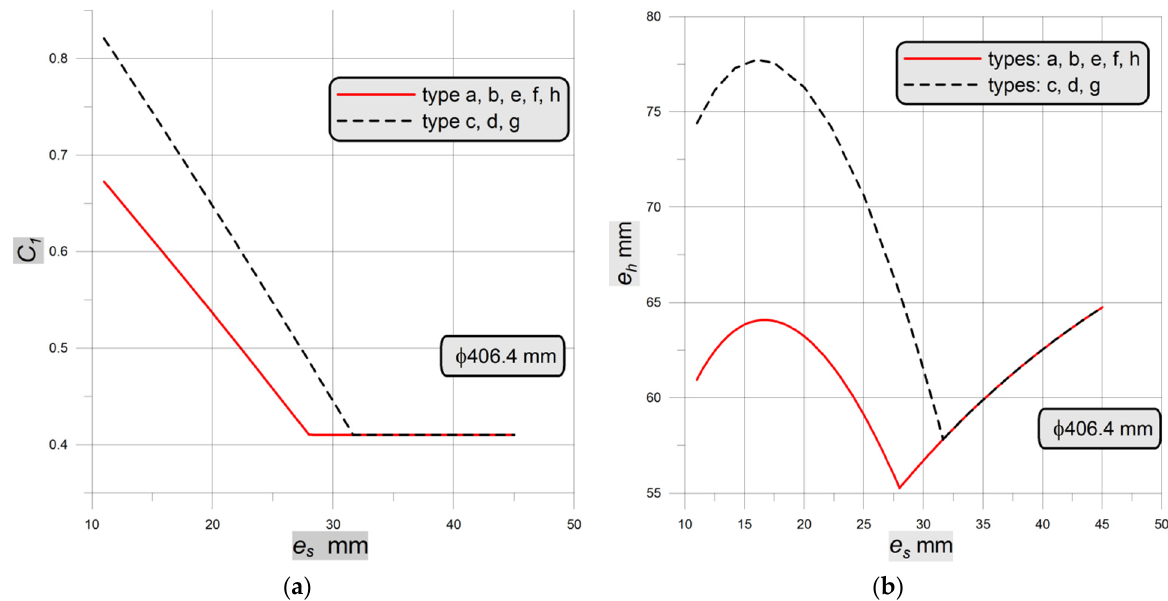
Figure 2. Dependency graph of: ( a ) C 1 constant; ( b ) endplate thickness e h .